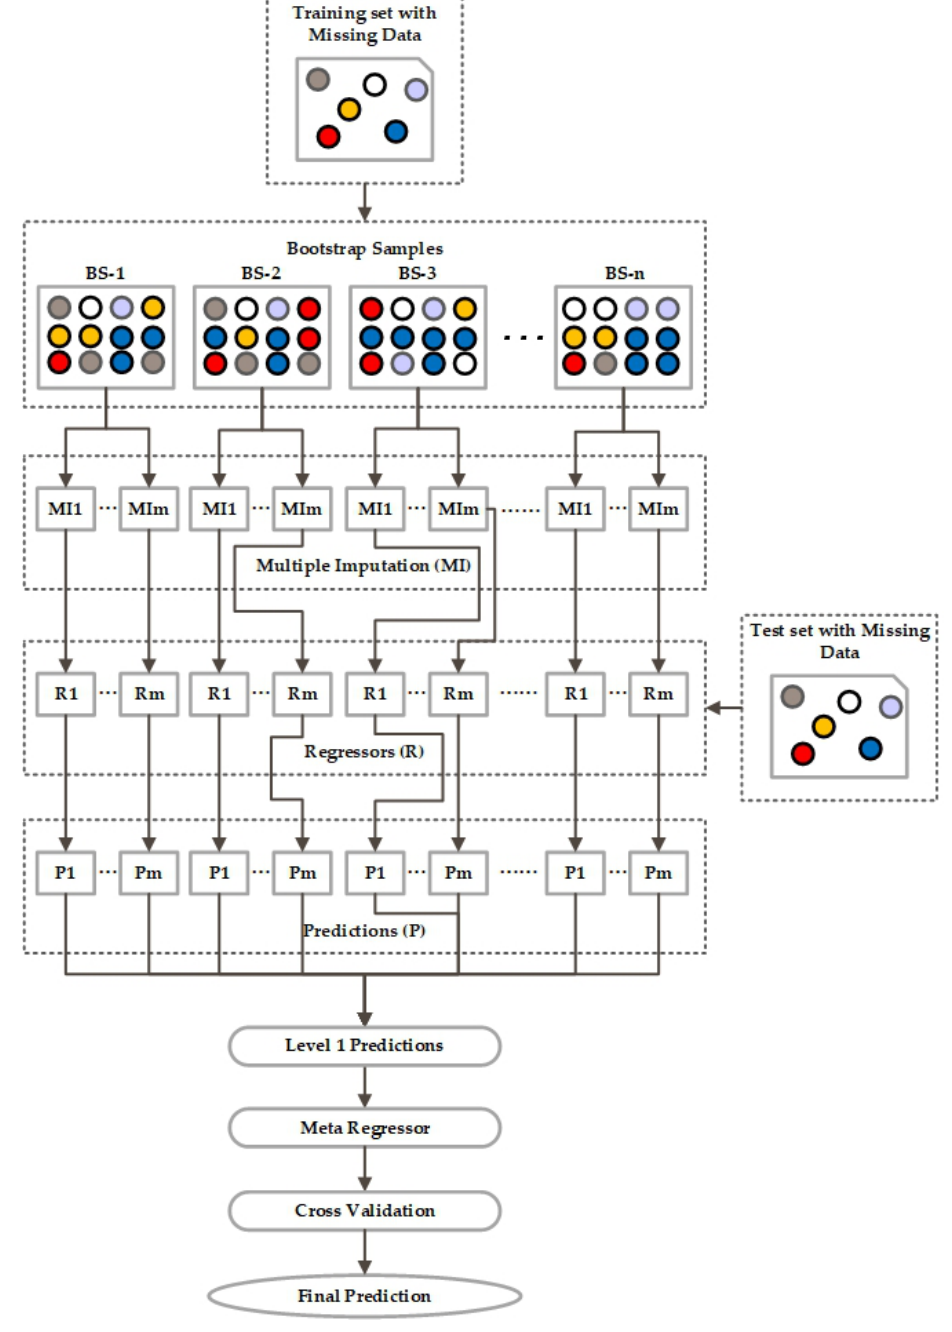
Figure 4. Architecture of Stacking